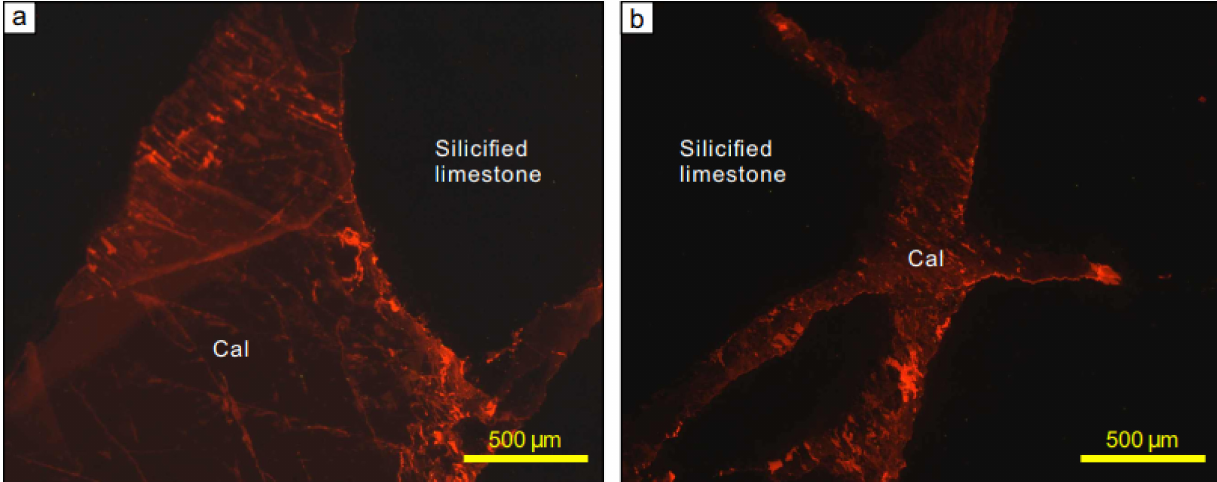
Figure 7. CL images of syn-stibnite calcite crystals in quartz-stibnite vein from the Xikuangshan Sb deposit (sample 37–27). ( a ) CL image of part of laser ablation area 4. ( b ) CL image of part of laser ablation area 3. The location is shown in Figure 6e. Abbreviations as in Figure